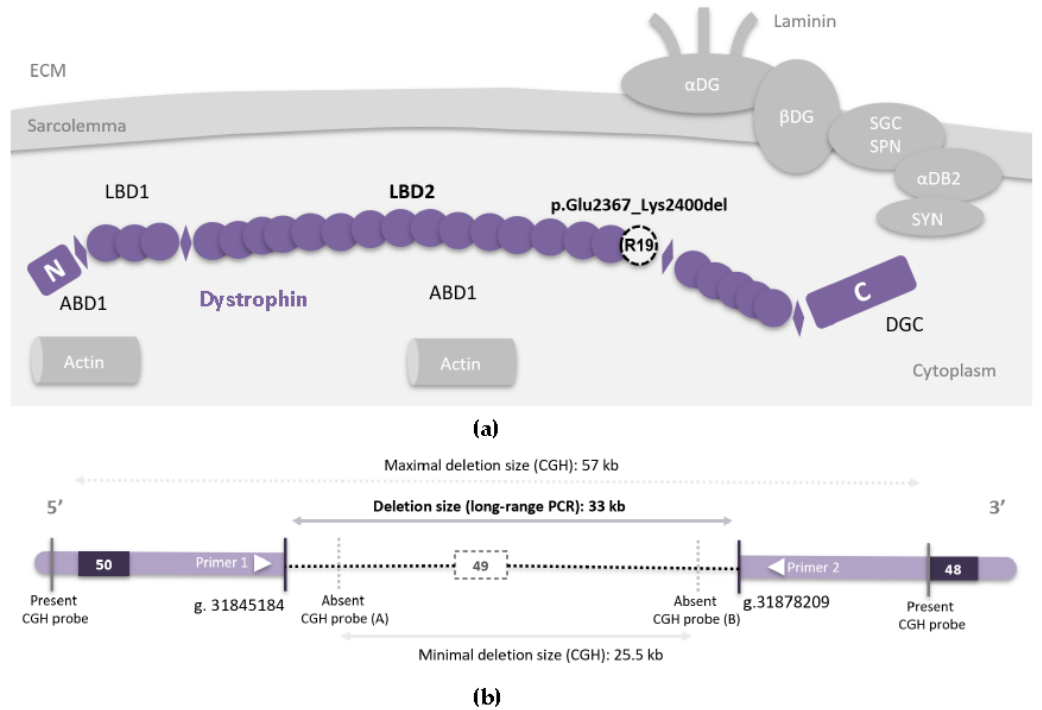
Figure 1. ( a ) Schematic representation of dystrophin (violet), a rod-shaped protein containing four main functional domains: an actin-binding amino-terminal domain (ABD1); a central rod domain composed of 24 spectrin-like repeats (R1–R24, represented by circles) interrupted by four proline-rich parts (H1–H4) which gives it more flexibility (represented by diamonds); a cysteine-rich domain; a carboxy-terminal domain. A second actin-binding domain (ABD2) extends from R11 to R17. Dystrophin has two membrane lipid-binding domains (LBD), the first one comprises the repeats R1 to R3 whereas the second one (LBD2) comprises repeats R4 to R19. This places dystrophin very near the sarcolemma with a large part of its central rod domain lying along the phospholipid membrane. R19 (LBD2), which is coded partially by exon 49, is represented by a dashed white circle. In the cellular context, dystrophin forms a complex with other proteins (DG: dystroglycans, SGC/SPN: sarcoglycan– sarcospan complex, DB: dystrobrevin, SYN: syntrophins). This complex plays an important role in signal transduction in addition to its mechano-protective role, which is indispensable for contractions and proper muscle function [3]. (DGC: dystrophin glycoproteins complex, ECM: extracellular matrix); ( b ) Schematic representation of exons 50, 49 and 48 in DMD (rectangles). The identified genomic deletion of exon 49 is represented by the dashed horizontal line. Genomic positions are mentioned using